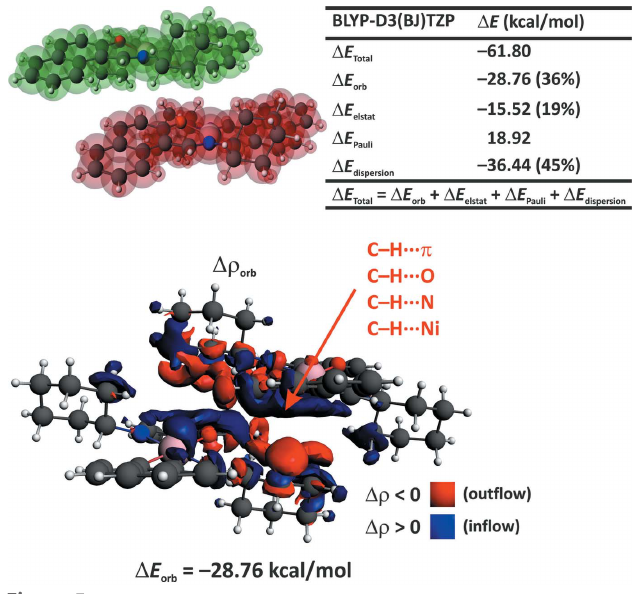
Figure 5 ETS-NOCV/BLYP-D3/TZP energy-decomposition results for the crystal dimer of [Ni( L II ) 2 ]. The considered model and ETS-based results (top), and the overall deformation density (cid:2) (cid:5) orb with the corresponding (cid:2) E orb